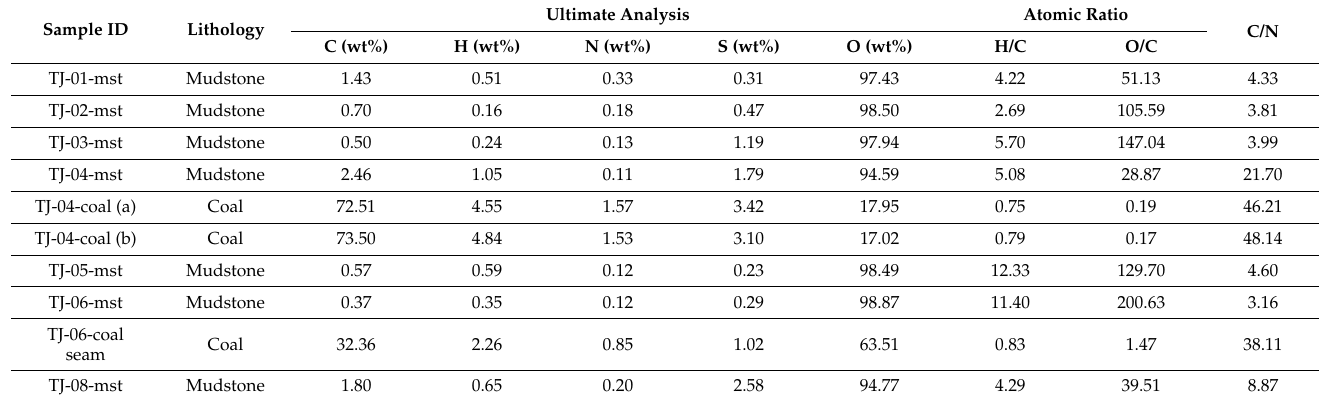
Table 3. Ultimate CHNS analysis with calculated oxygen of the studied mudstone and coal samples.